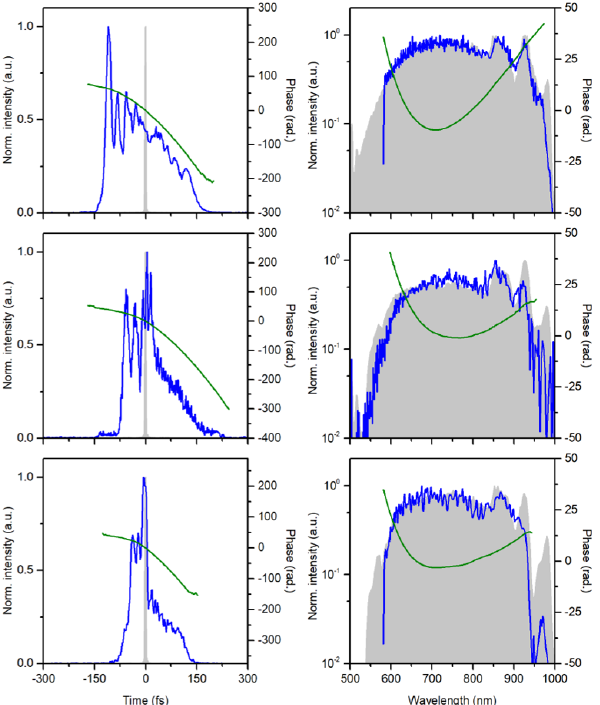
Figure 14. Temporal and spectral plots of PG ‐ FROG measurements corresponding to Figure 13.